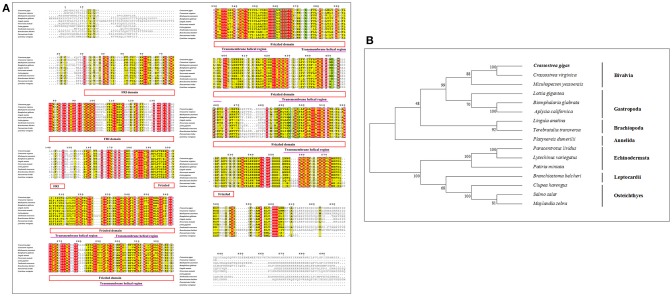
(A) Multiple sequence alignment of the CgPtc amino acid sequence among species. The conserved functional structure are marked in box. Identical residues are shown as white letters with red background, and similar residues are shown as black letters with yellow background. (B) Neighbor-joining phylogenetic tree based on the amino acid sequences of the CgPtc.